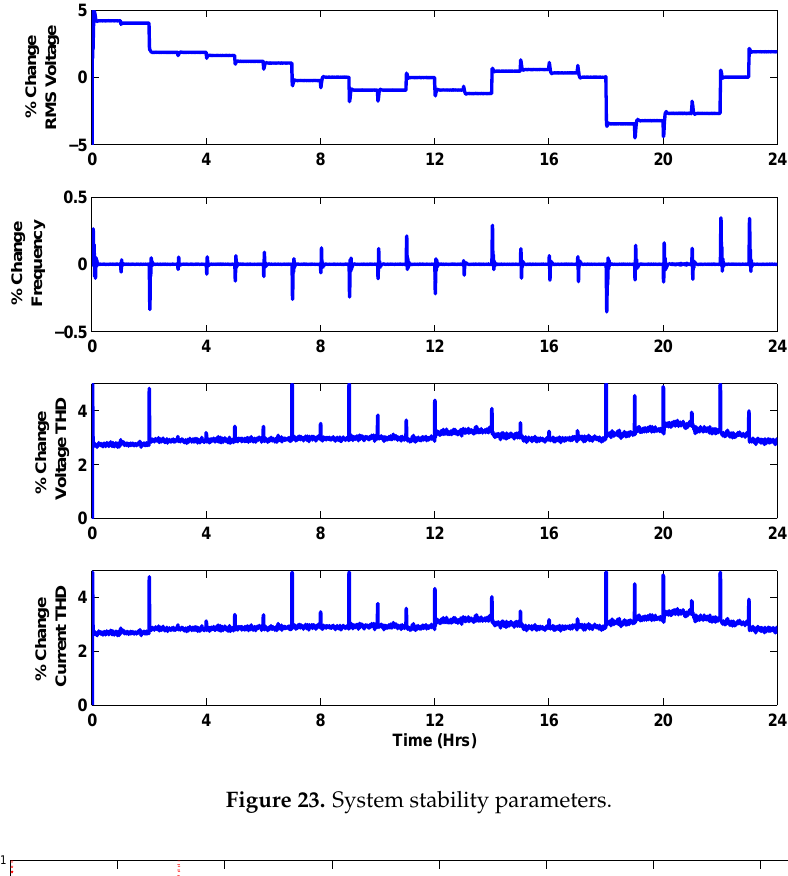
Figure 23. System stability parameters.